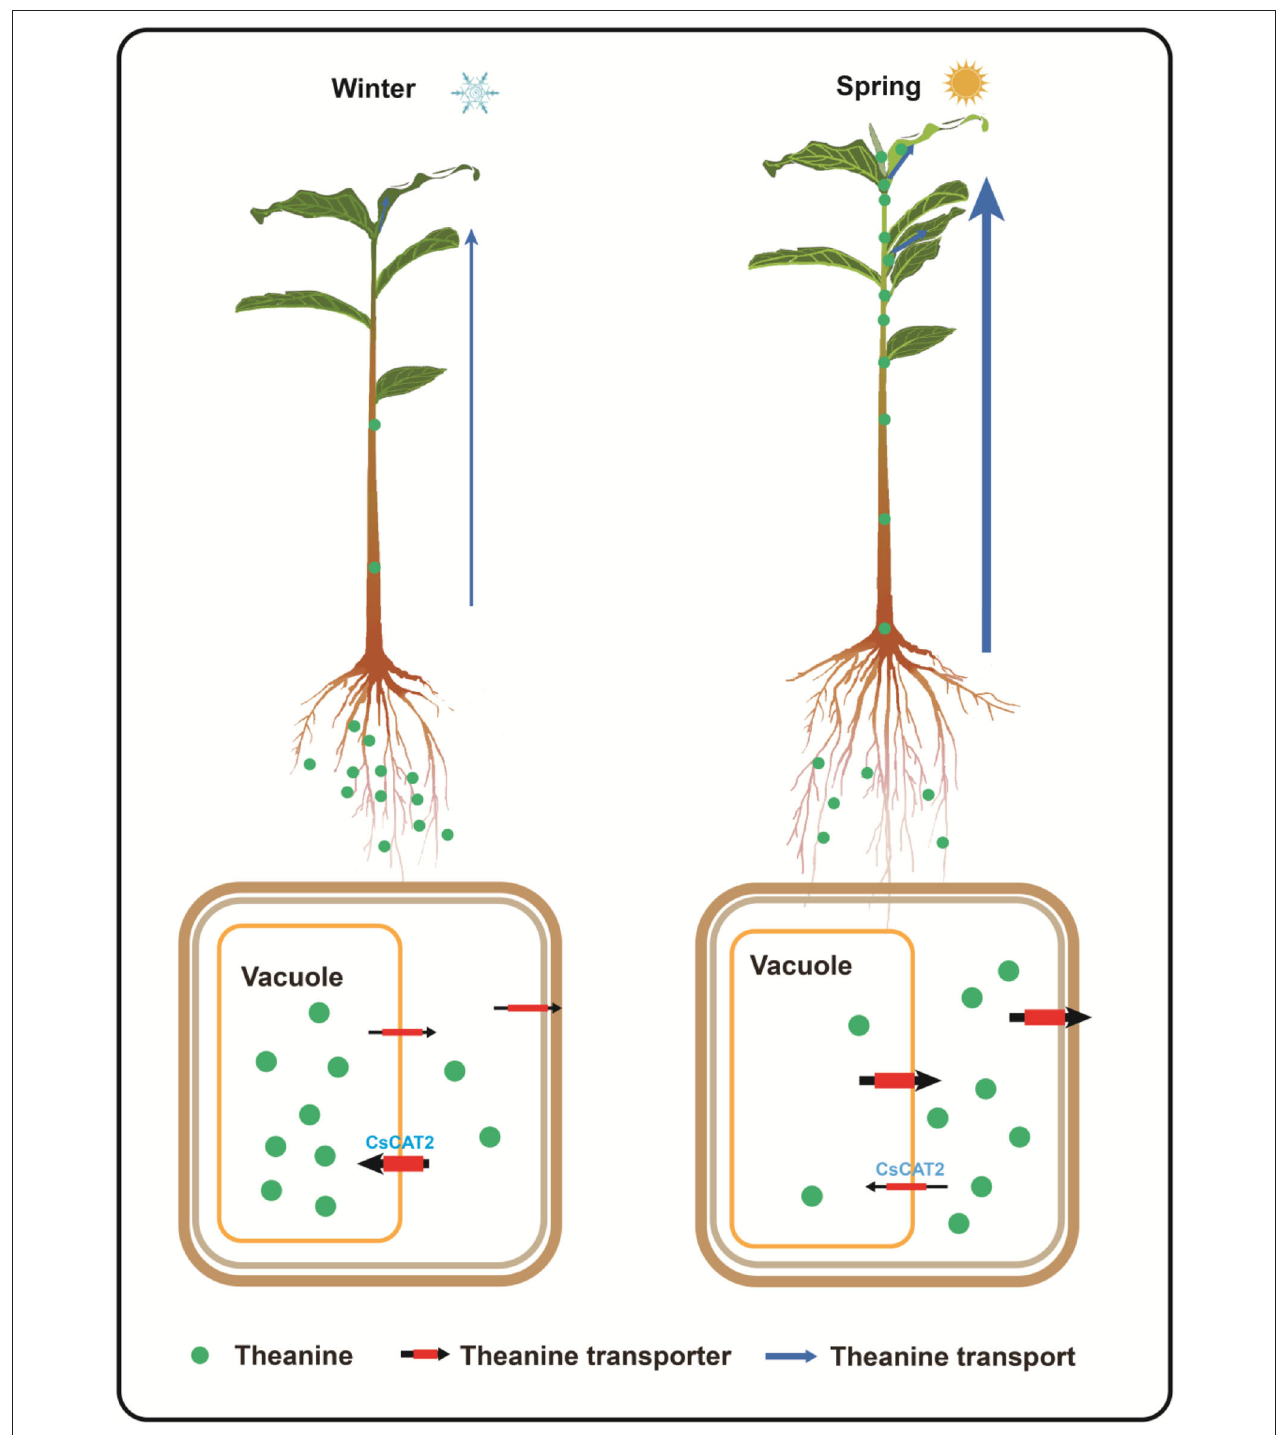
FIGURE 7 | Proposed model for theanine storage and root-to-shoot transport in tea plants. In winter, theanine is transported into vacuole for storage; in spring, theanine is exported from vacuole into cytoplasm and is then transported out of the storage cells for root-to-shoot transport. CsCAT2 likely mediates theanine transport into the vacuole. High expression of CsCAT2 in winter confers efficient transport of theanine into vacuole; however, high expression of CsCAT2 in spring reduces the efficiency of theanine root-to-shoot transport.